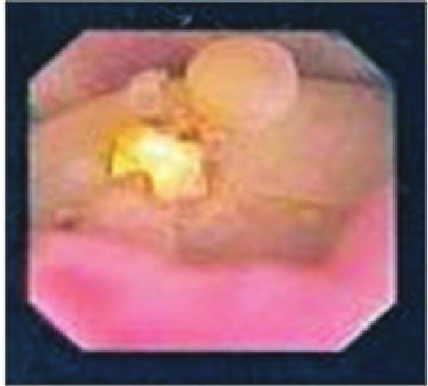
Figure 2: Renal calculus containing Weck Hem-o-lok clip as seen on flexible